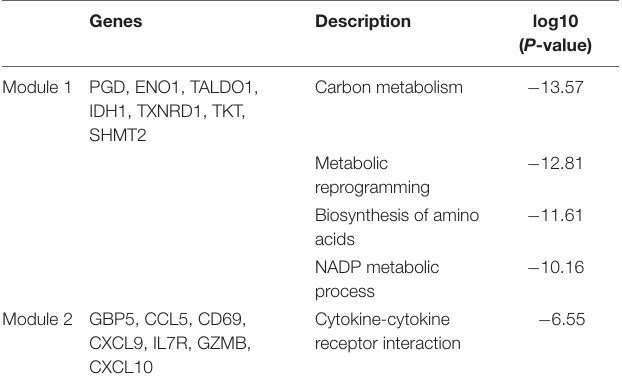
TABLE 3 | MCODE module. Genes Description log10